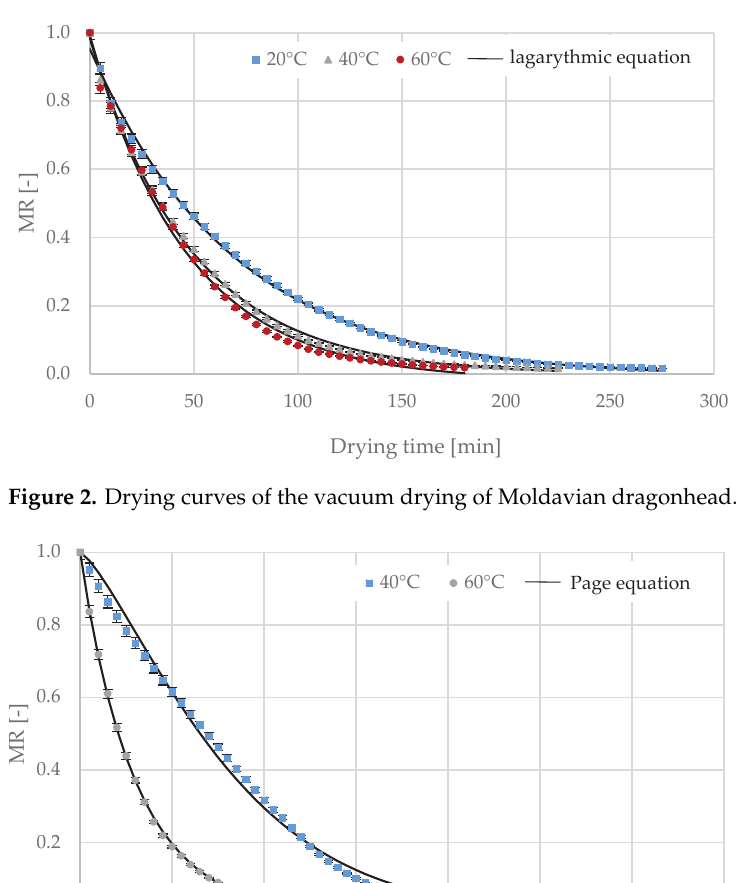
Figure 1. Drying curves of the freeze-drying of Moldavian dragonhead.